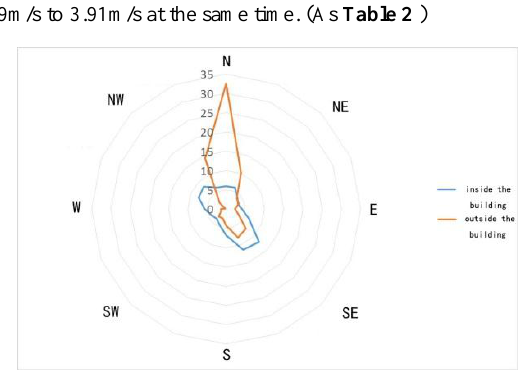
Figure 1 Wind direction diagram inside and outside the experimental structure